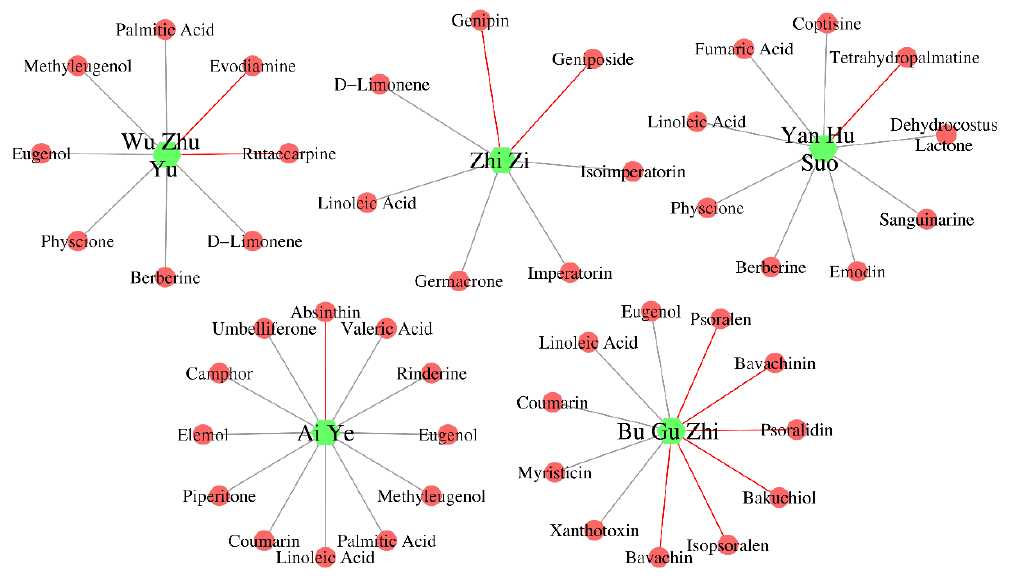
Figure 5. Hepatotoxic ingredients identified by the herb-ingredient network for Wu Zhu Yu, Zhi Zi, Yan Hu Suo, Ai Ye, and Bu Gu Zhi. The green hexagons and red circles indicated hepatotoxic herbs and hepatotoxic ingredients, respectively.